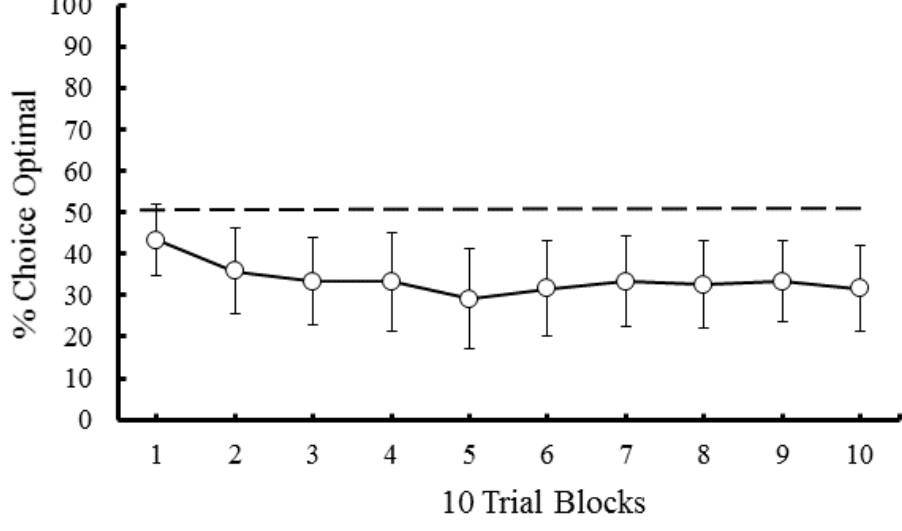
Figure 1 . Pigeons’ performance on the manually presented ephemeral reward task (error bars = ±SEM; after Zentall et al., 2016, Experiment